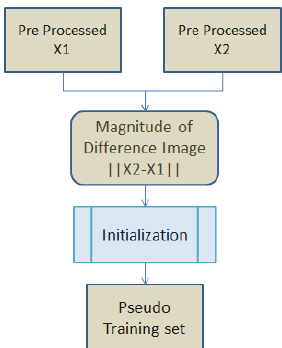
Figure 1. Figure placement and numbering